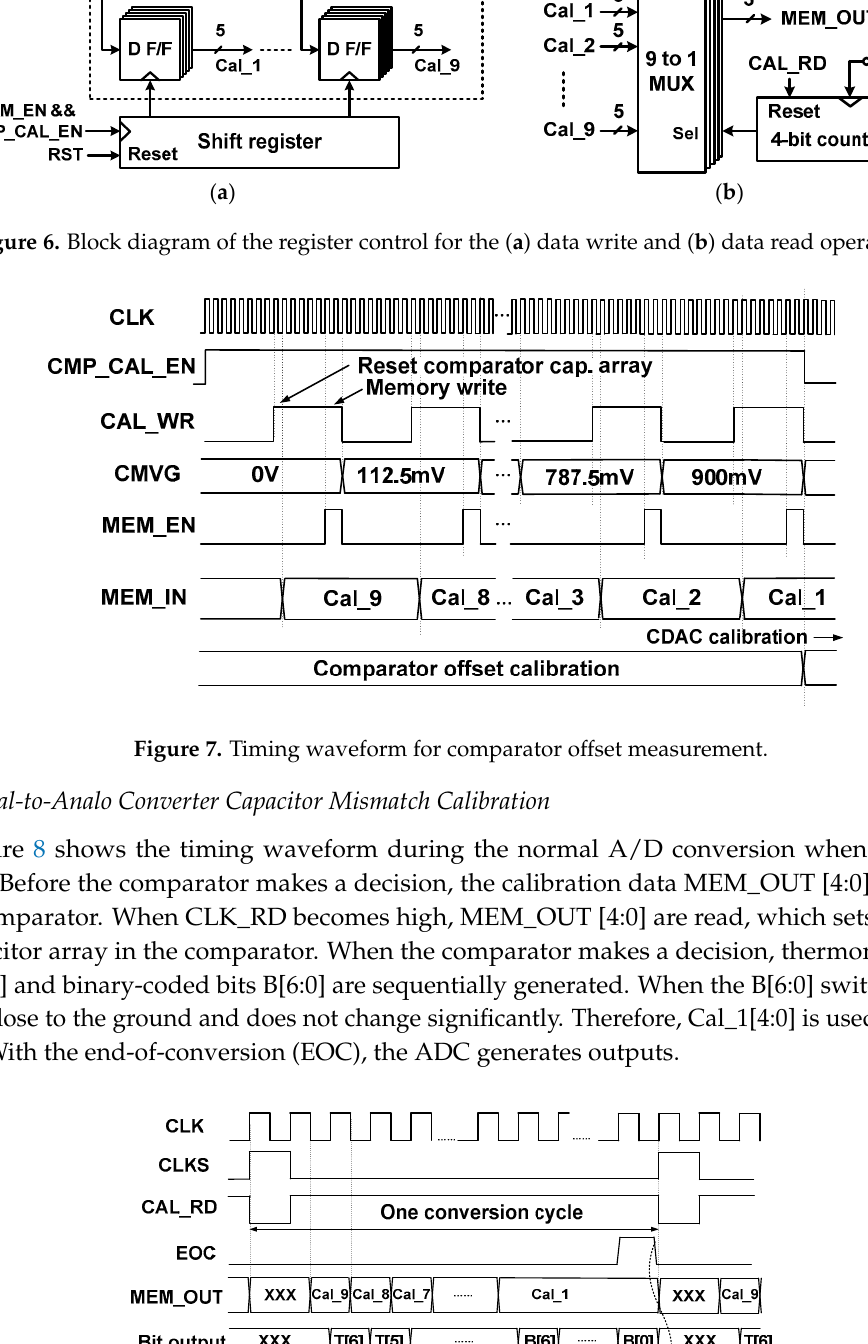
Figure 8. Timing waveform during normal A/D conversion when the offset calibration data are applied.